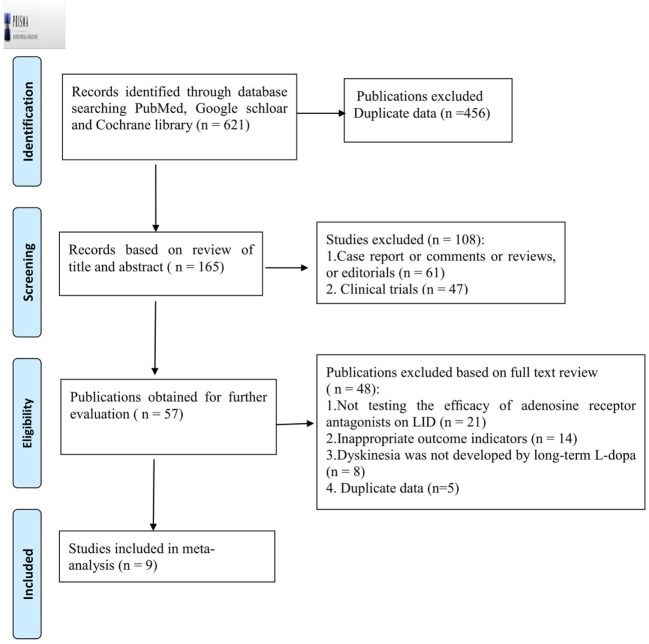
PRISMA 2009 Flow Diagram of trial identification, inclusion, and exclusion. LID, levodopa-induced dyskinesia.